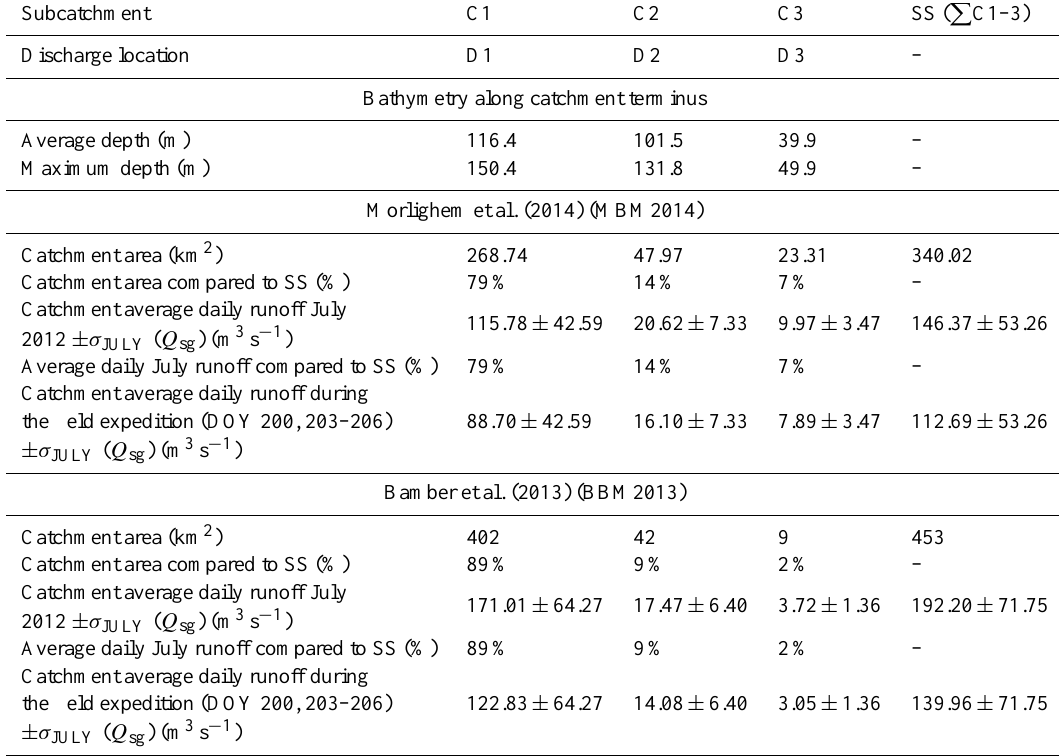
Table 3. Saqqarliup sermia subcatchments and runoff